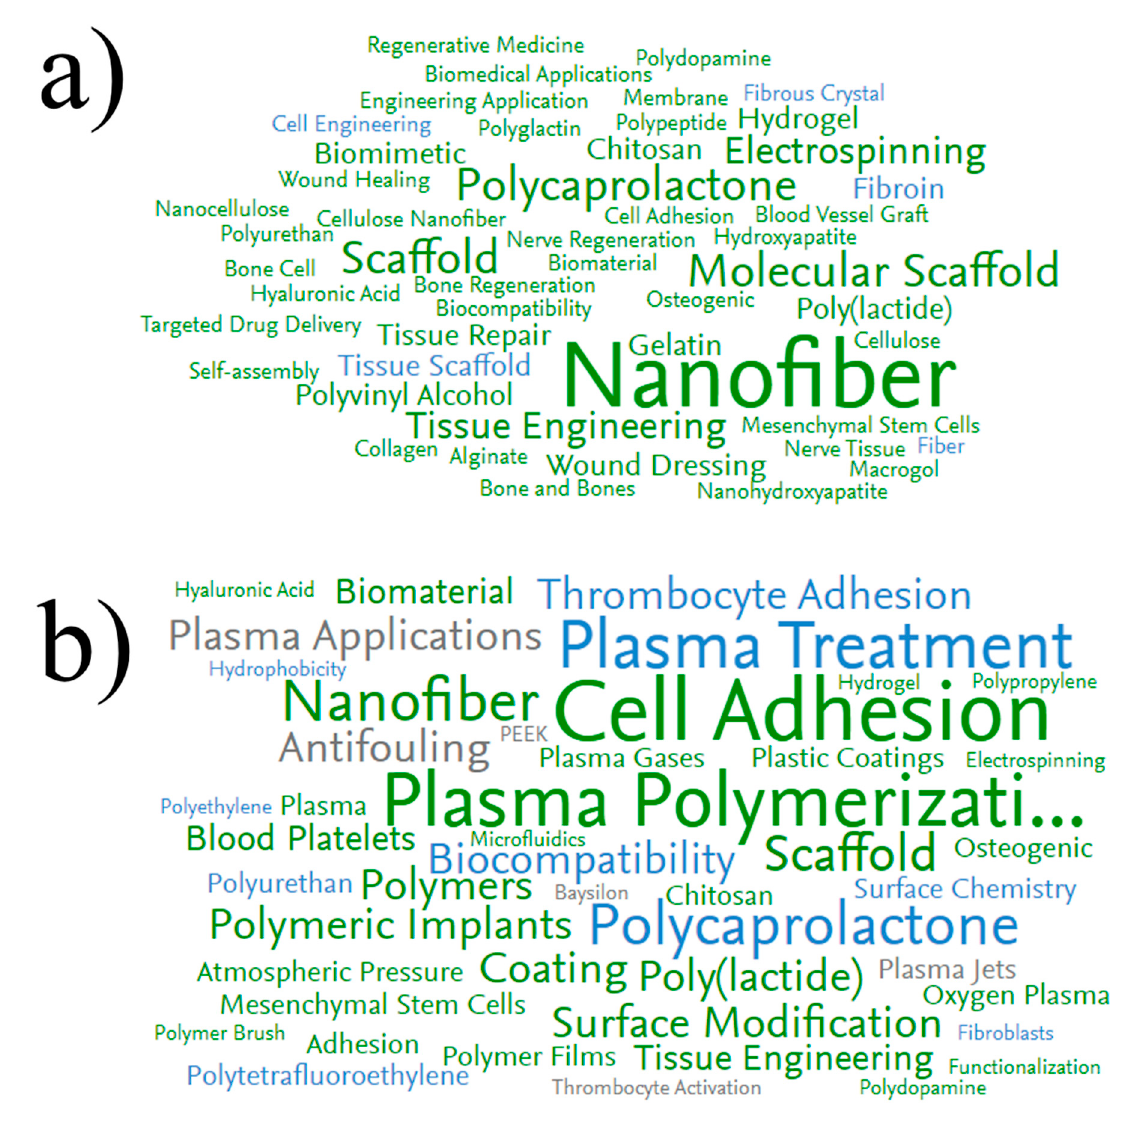
Figure 2. Keyword distributions by frequency of use when searching in Scopus for the keywords “CELL & ADHESION & NANOFIBERS” ( a ) and “PLASMA & POLYMER & CELL & ADHESION” ( b ). Font size corresponds to keyword relevance (larger font size corresponds to higher frequency of the keyword appearance in the dataset). The color corresponds to the decreasing (blue) or increasing (green), or does not changing (grey) current trend of the keyword usage.